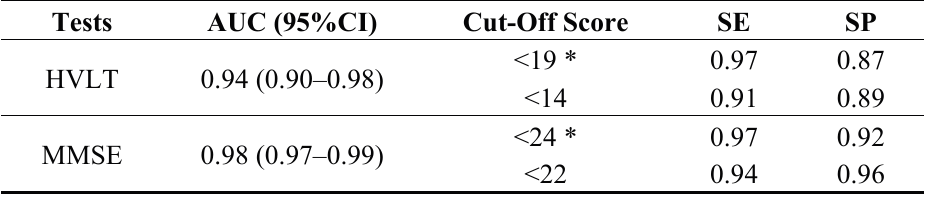
Table 2. Area Under Curves (AUCs), optimal cut-off scores, sensitivity (SE) and specificity (SP) for the HVLT and the MMSE in discriminating dementia patient from non-dementia subjects.